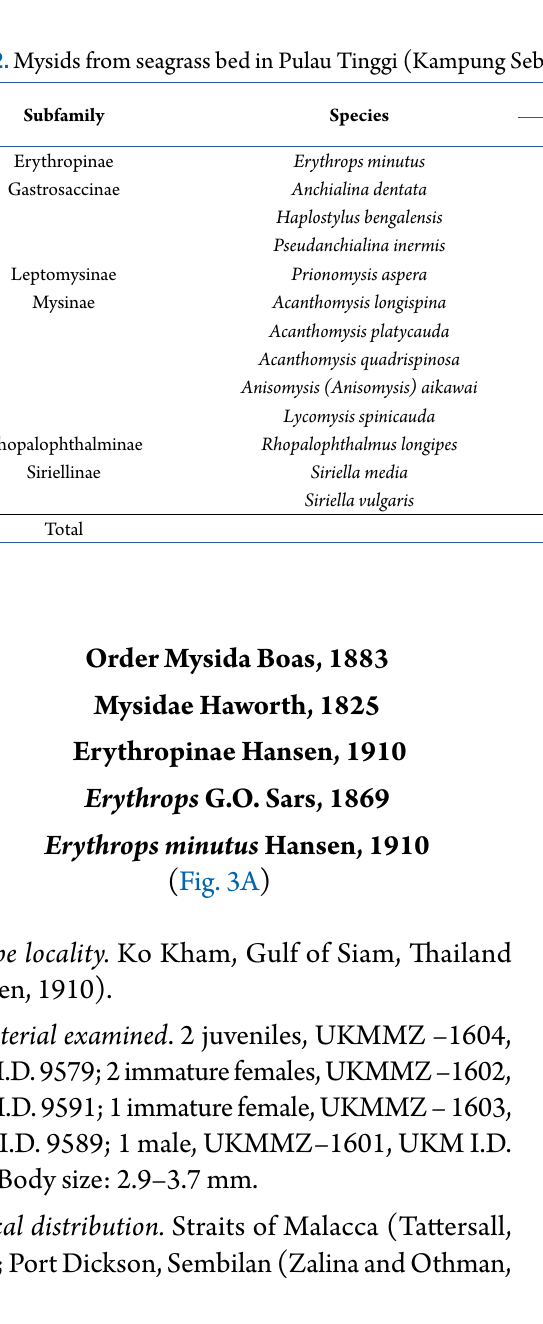
Leptomysinae Prionomysis aspera Mysinae Acanthomysis